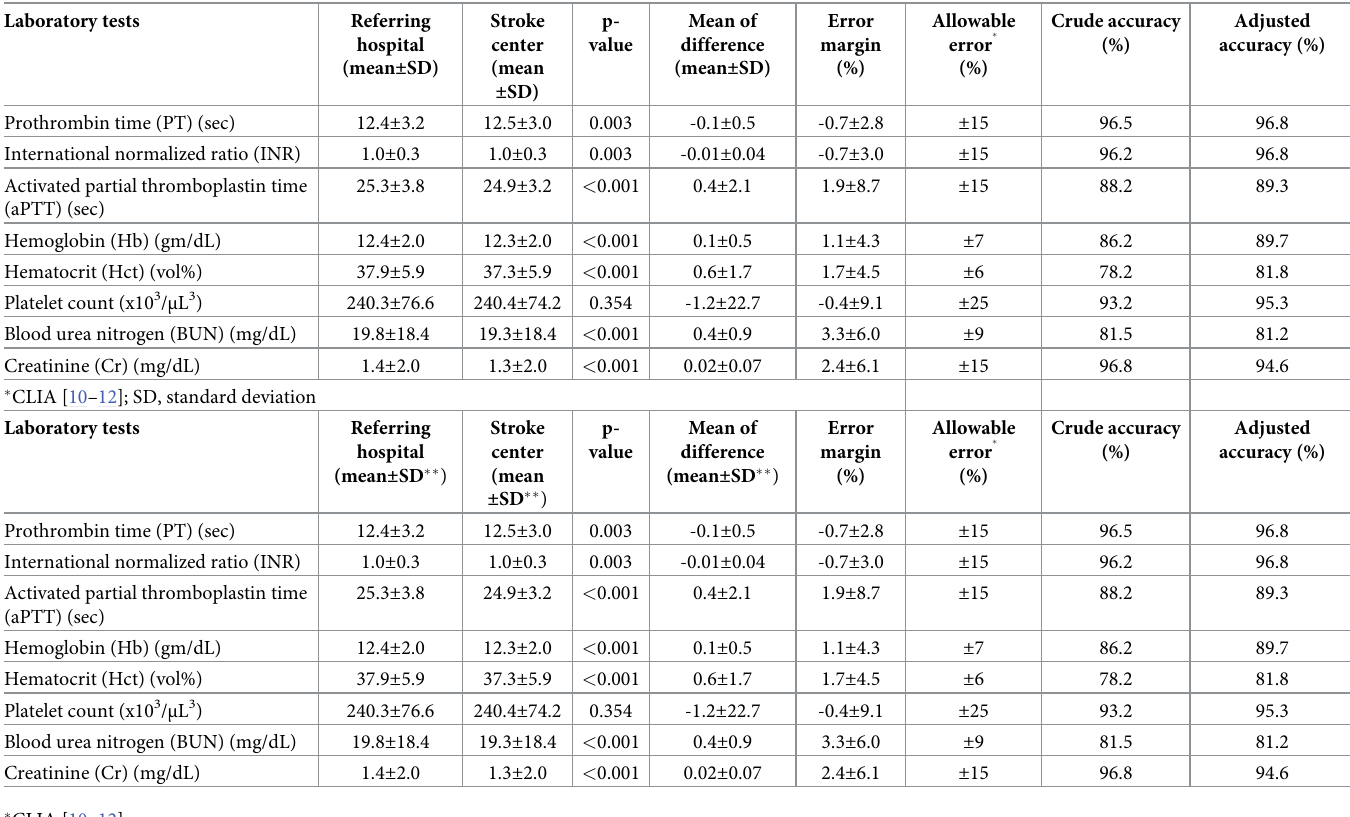
Table 2. Comparison of laboratory tests from referring hospitals vs. stroke